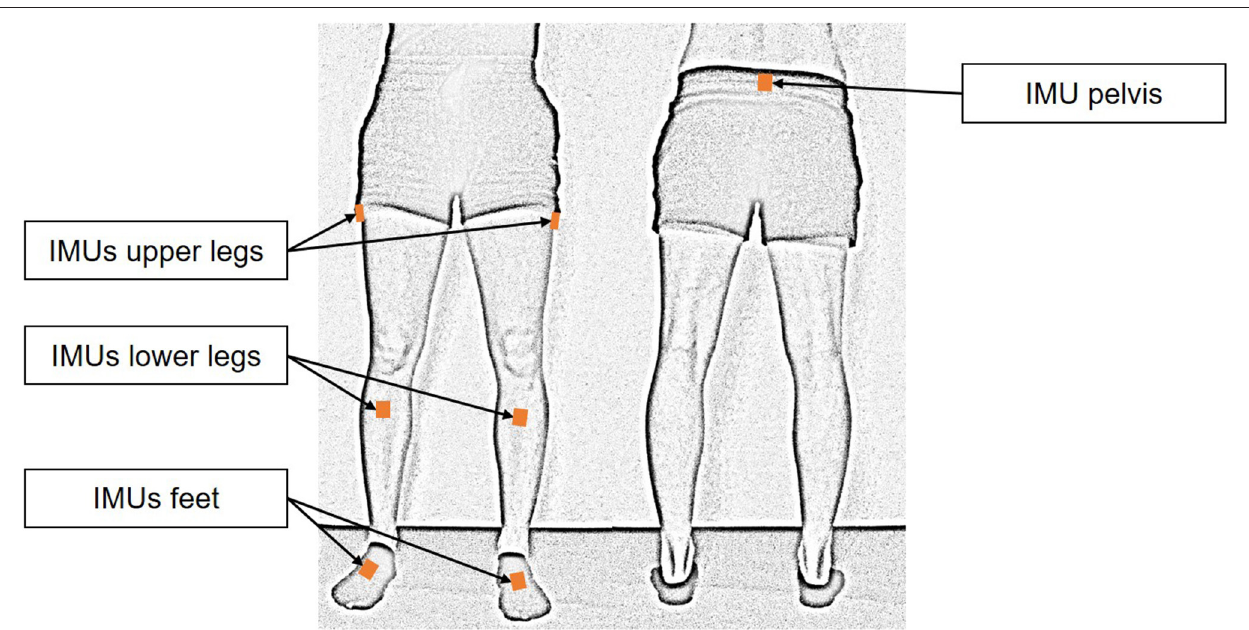
FIGURE 1 | Positioning of the inertial measurement units. Seven sensors were fixed to the patient’s body with Velcro straps according to the specifications of the MVN Awinda